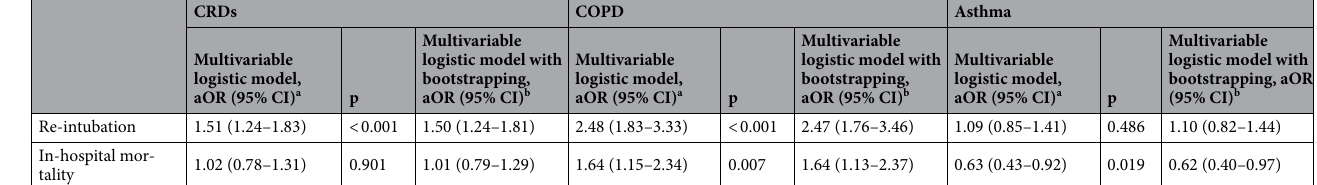
Table 3. Associations between clinical outcomes and different respiratory diseases. CRDs chronic respiratory diseases, COPD chronic obstructive pulmonary disease, aOR adjusted odds ratio. a Multivariable logistic model was used to evaluate the association between clinical outcomes and different respiratory diseases. All these models were adjusted for same co-variables, including age, hypertension, coronary disease, renal replacement therapy, duration of intubation, haemoglobin level, white blood cell count, serum sodium level, and vasopressor use. b 95% CI using bootstrap techniques (100 resamples) was adjusted for the same co-variables listed